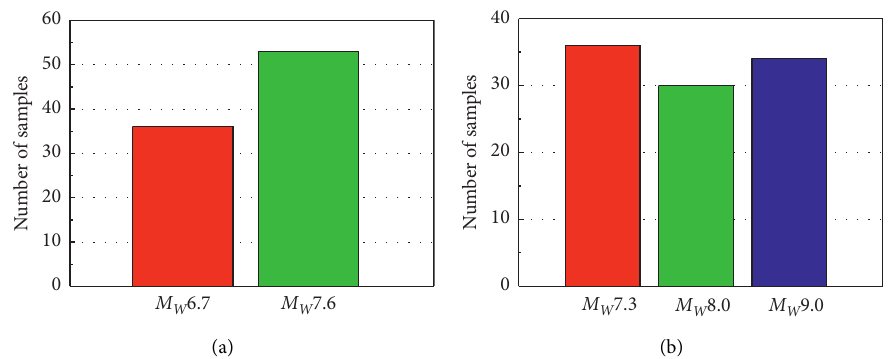
Figure 3: Numbers of samples in each earthquake magnitude. (a) Near-fault pulse-like ground motions. (b) Far-field harmonic ground